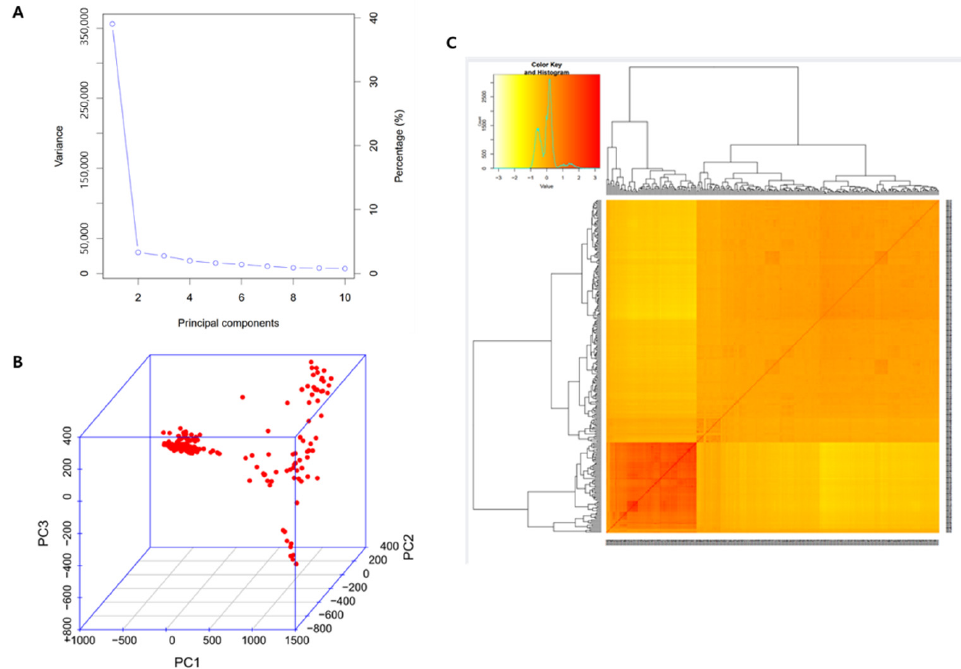
Figure 3. Population structure analysis of the 294 rice core collection. ( A ) Variance of the first 10 principal components reflected by 1,842,515 SNPs in GWAS, ( B ) principal component analysis (PCA) of SNPs, indicating the population structure of the core collection, ( C ) kinship plot showing the relationship among the genotypes.